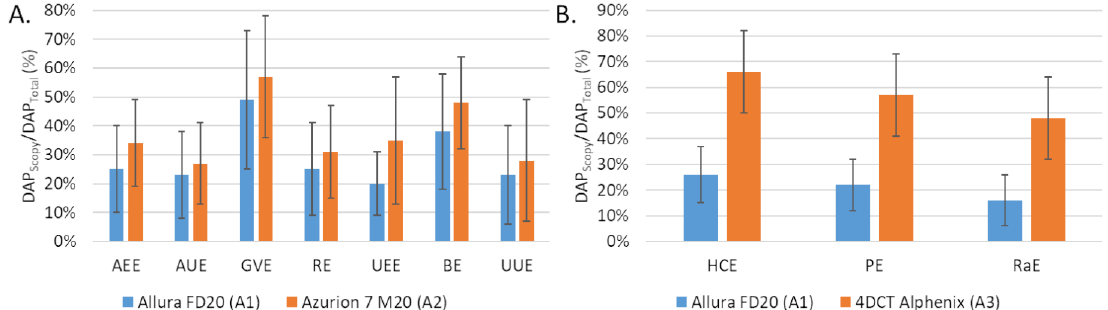
Figure 2. Comparison of the fluoroscopy dose area product (DAP) to total DAP ratio ( A ) between the Allura FD20 (A1) and Azurion 7 M20 (A2) systems for 7 embolization procedures and ( B ) between the Allura FD20 (A2) and 4DCT Alphenix (A3) systems for 3 embolization procedures. Values are expressed as means ± standard deviations (error bars). DAP: dose area product; AEE: abdominal elective embolizations for tumors and visceral aneurysms; AUE: abdominal urgent embolizations for active bleedings or vascular injuries of digestive arteries; BE: bronchial artery embolizations; HCE: hepatic chemoembolizations; PE: pelvic embolizations for planned prostatic embolizations; RaE: ra- dioembolisations; RE: renal artery embolizations; UEE: uterine elective embolizations for leiomyomas or vascular malformations; UUE: uterine urgent embolizations for postpartum hemorrhages; GVE: gonadal vein embolization.